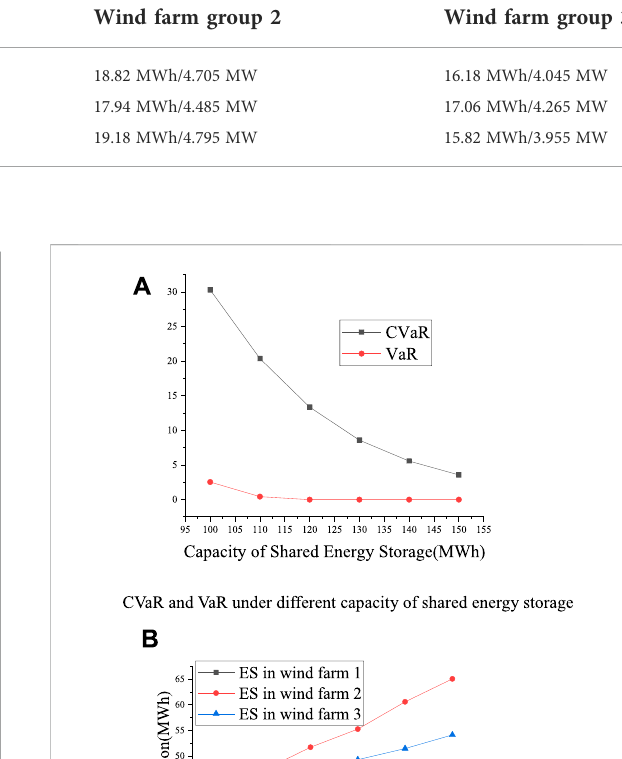
FIGURE 9 VaR and CVaR under different con fi dence levels.